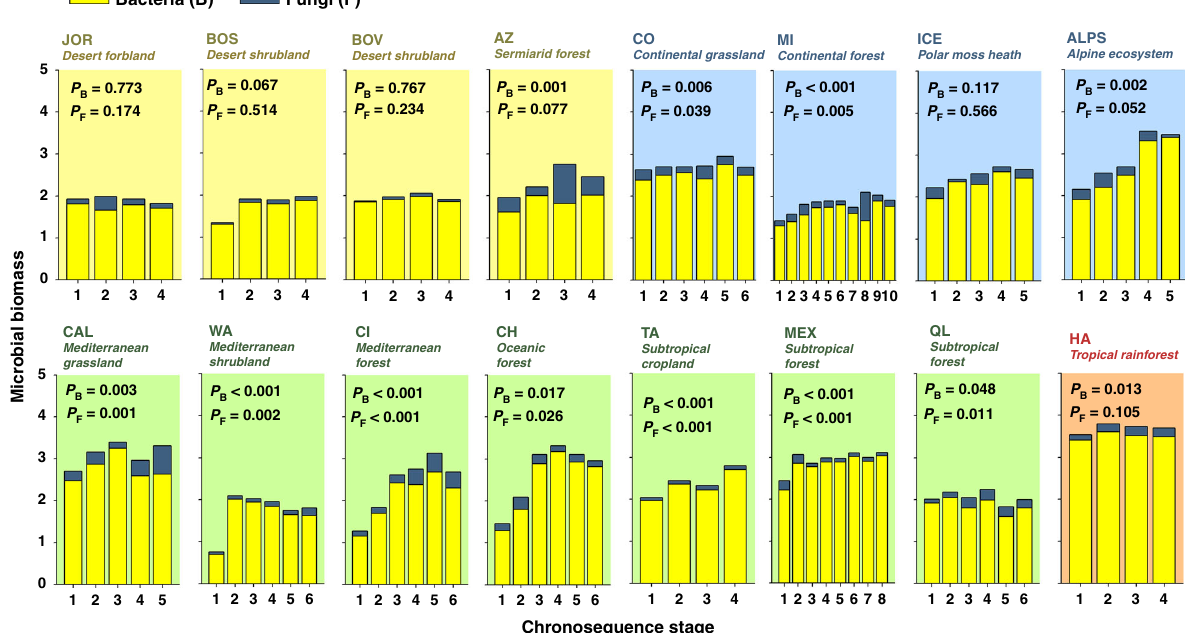
Fig. 6 Changes in bacterial and fungal biomass during ecosystem development. Microbial biomass (mean values) = nmol PLFA g − 1 dry soil (log 10 - transformed). Acronyms for different chronosequences are available in Supplementary Fig. 1. PERMANOVA P -values are shown. Chronosequence stage was included as a fi xed factor in these analyses ( n = 5).